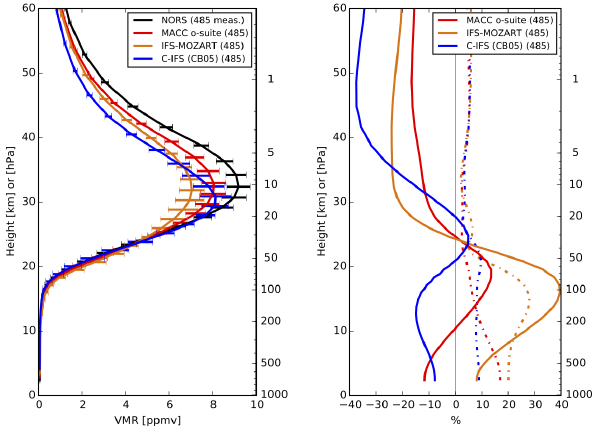
Figure 9. Comparison of the average O 3 mixing ratios of MACC o-suite (red), IFS–MOZART (orange) and C-IFS (CB05) (blue) with the average NDACC FTIR profiles (black) observed at Izaña (28.3 ◦ N, 16.5 ◦ W) for the period September 2013– September 2014. (Left) O 3 profiles, (right) profiles of the bias and standard deviation of the differences centred on the bias. The num- ber of available O 3 profiles and the number of collocated model profiles are indicated in between